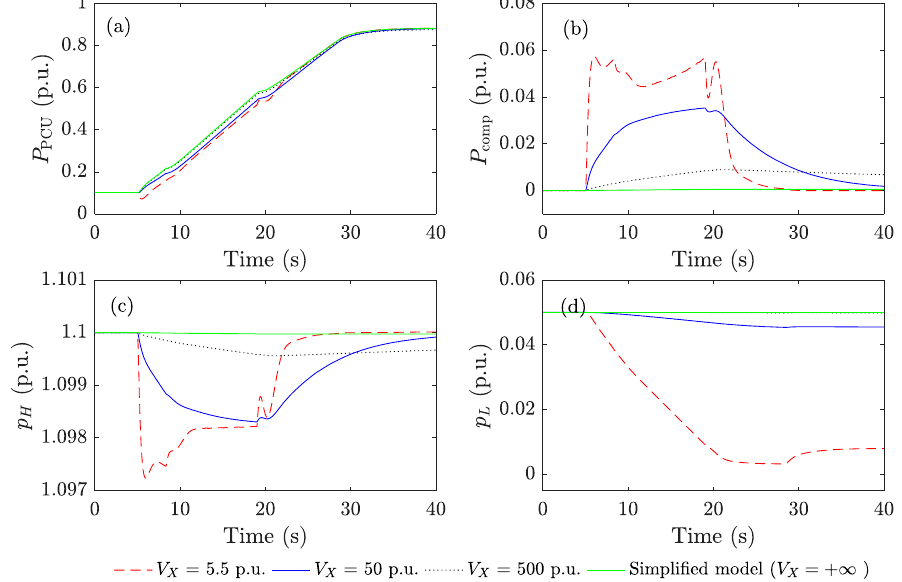
Figure 11. Comparison of simulation results using a different hydrogen supply system model with different tank volumes: ( a ) power generated by the PCU, ( b ) power consumed by the gas compressor, ( c ) gas pressure in the high pressure tank, and ( d ) gas pressure in the low pressure tank.